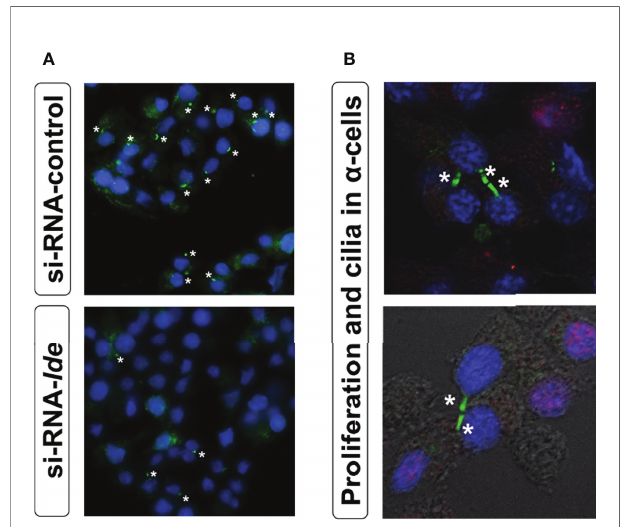
FIGURE 4 | (A) Loss of IDE expression reduces ciliated a -cells number. Representative epi fl uorescence microscopy (40X zoom) images of cilia signal in siRNA- Ide - and control-treated a -cells. Acetylated a -tubulin (green) and DAPI (blue). Asterisks indicate the presence of cilia. (B) Primary cilium and proliferation in a -cells. Representative fl uorescence microscopy images of cilia signal obtained with confocal microscopy (60X zoom) in non-permeabilized a - cells. As seen in the images, proliferation (BrdU staining) was associated with unciliated cells. Acetylated a -tubulin (green), DAPI (blue), and BrdU